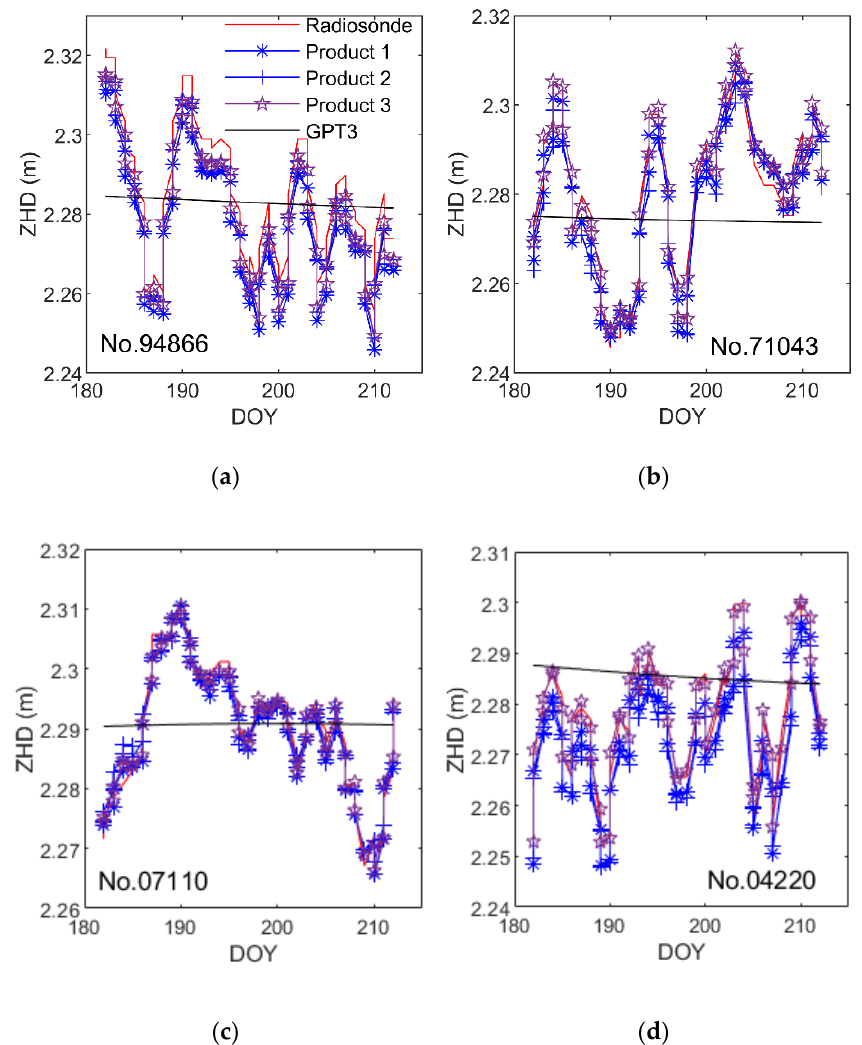
Figure 5. Time series of the ZHD obtained from GPT3 model and VMF1/VMF3 forecasting products in July 2018 at four radiosonde stations (DOY represents “day of year”). ( a ) ZHD time series at No. 94866. ( b ) ZHD time series at No. 71043. ( c ) ZHD time series at No. 07110. ( d ) ZHD time series at No. 04220.